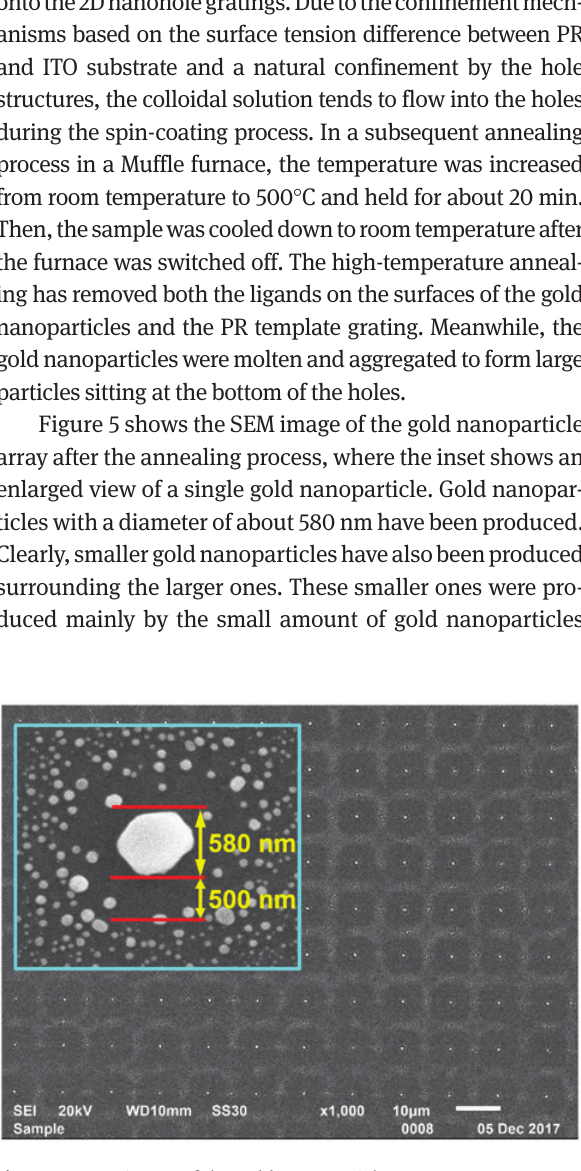
Figure 5: SEM image of the gold nanoparticle array. Inset: enlarged view of a single gold